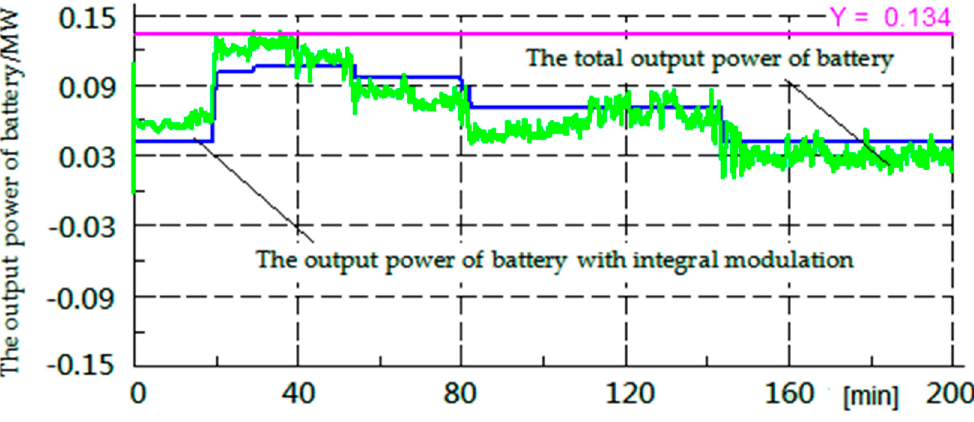
Figure 11. The output power curve of the battery.